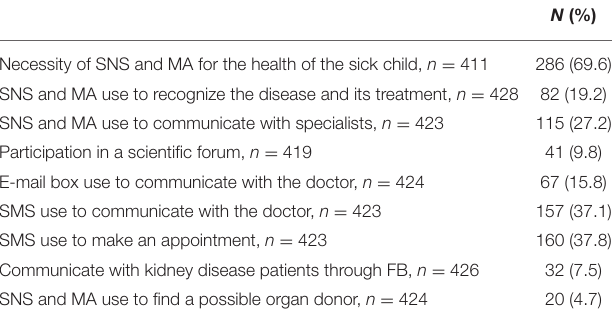
TABLE 2 | Positive responses to the different items of the survey